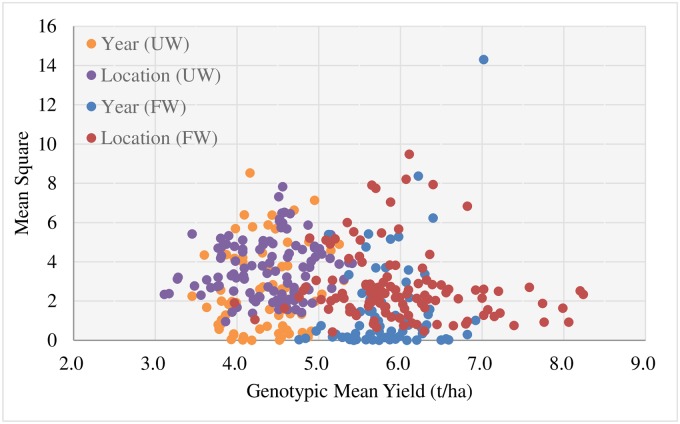
Genotypic performance over years and across locations calculated from individual trial analysis.